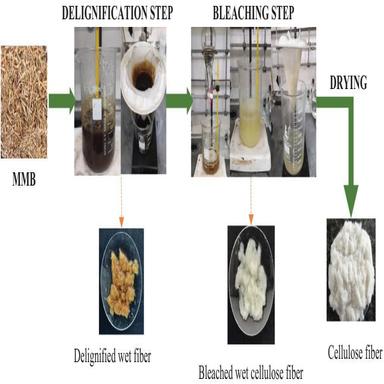
Extraction process of the cellulose fibers from MMB.